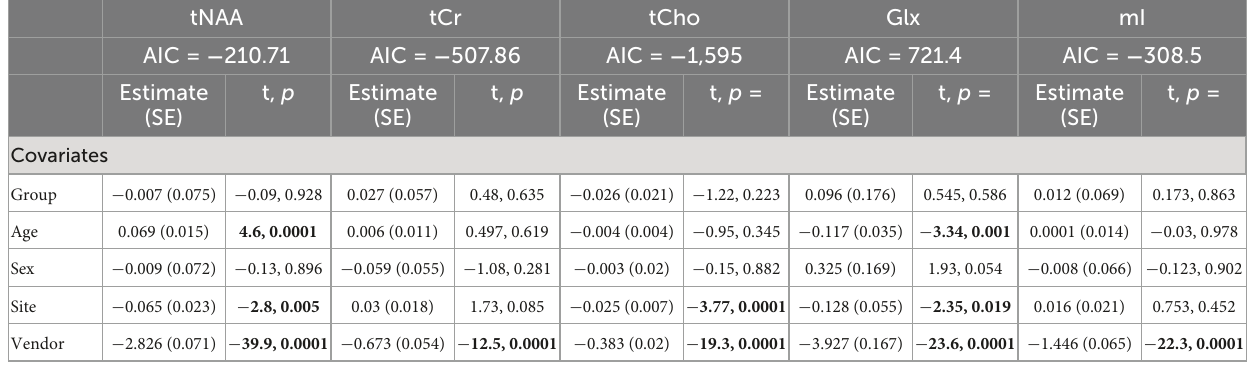
TABLE 2 Summary of the independent univariate general linear model (GLM) models for each metabolite (tNAA, tCr, tCho, Glx, and mI) to investigate group differences (concussion vs. OI) in the metabolite concentrations (Model 1).